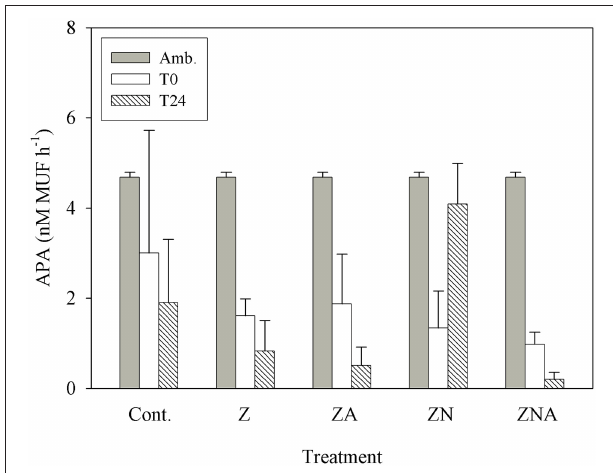
FIGURE 6 | Measured changes in alkaline phosphatase activity between T 0 and T 24 (hours) for the control and all treatments (Z, ZA, ZN, and ZNA).